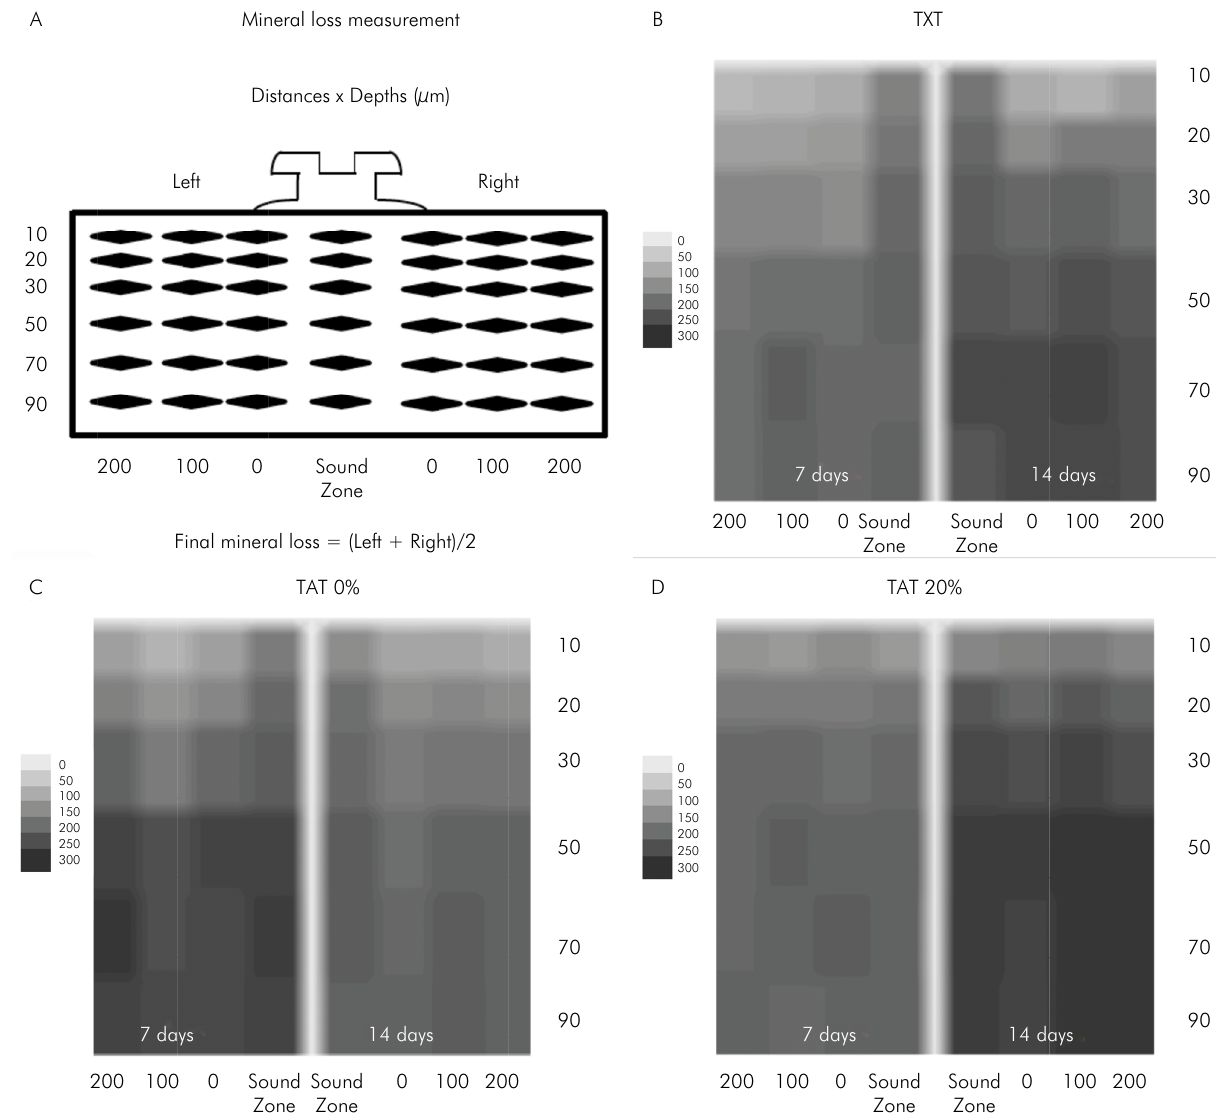
Figure 4. (A) Representative image of the microhardness evaluation at different depths (10, 20, 30, 50, 70 and 90 µm) and different distances (Sound zone, 0, 100, and 200 µm). The equation used for mineral loss measurement is shown. (B) Mineral content increased after 14 days; however, at 10 and 20 µm deep, mineral loss may be observed comparing the different distances to the “sound zone”. (C) Mineral loss may be observed between the different distances (in µm) and the “sound zone”; the mineral loss increased at 7 days compared to 14 days. (D) Mineral content increased at 7 days compared to 14 days and no alterations were observed between “sound zone” and the different distances (in µm).